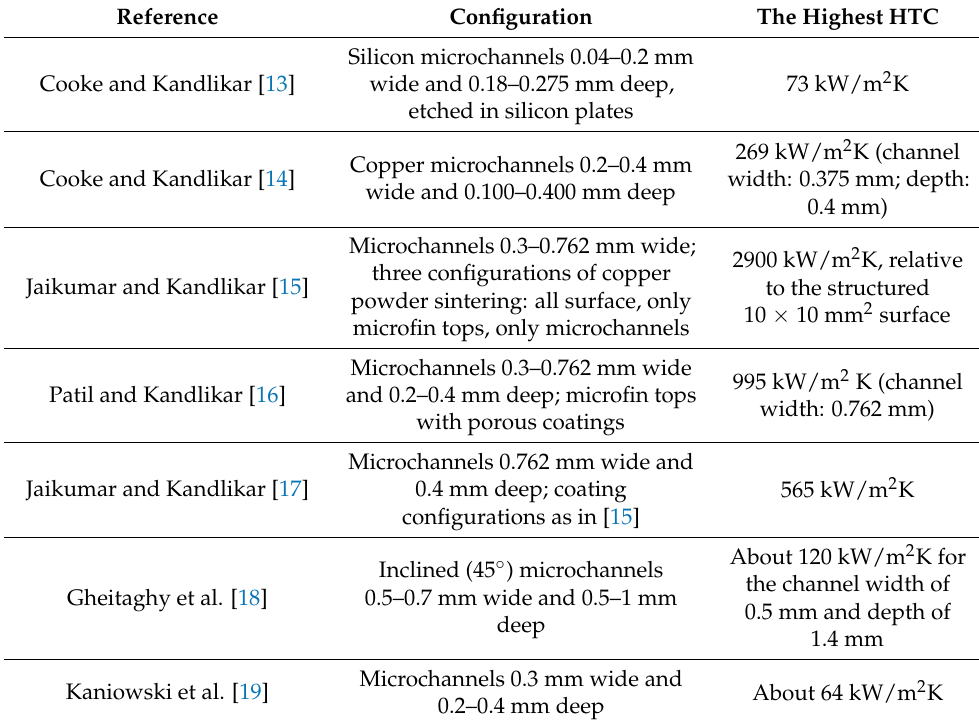
Table 1. Types of open